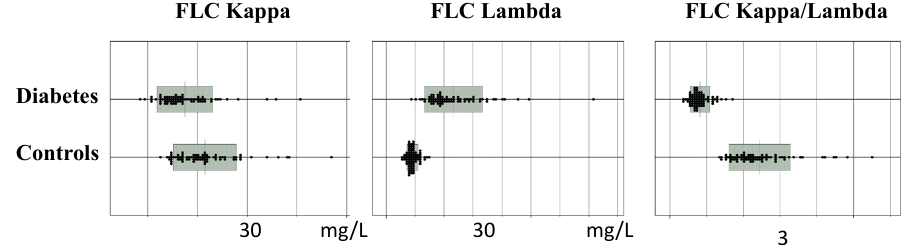
Figure 1. Immunoglobulin-free light chains (FLCs) in patients with type 2 diabetes and healthy controls (Adapted from [13]).